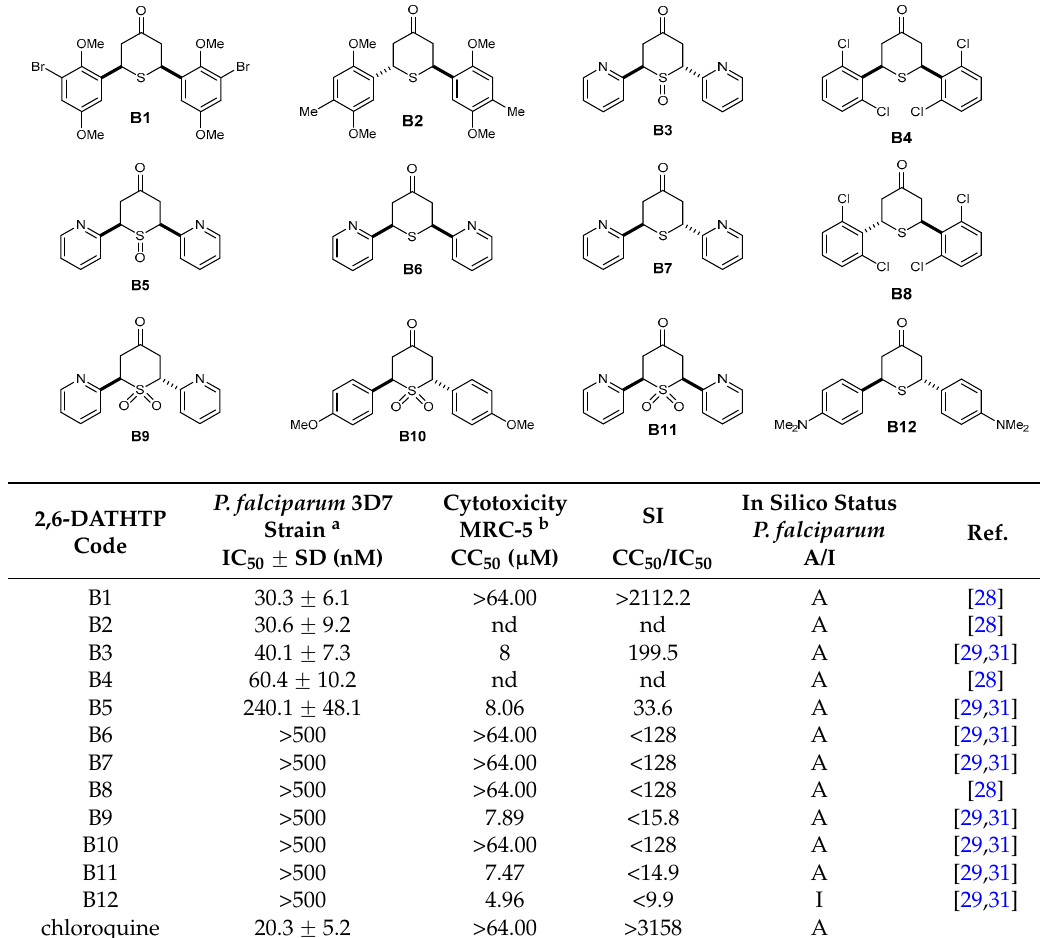
Table 2. Structures of 2,6-diaryltetrahydrothiopyran-4-ones (2,6-DATHTP), antimalarial effects, cytotoxicity and predicted activities.